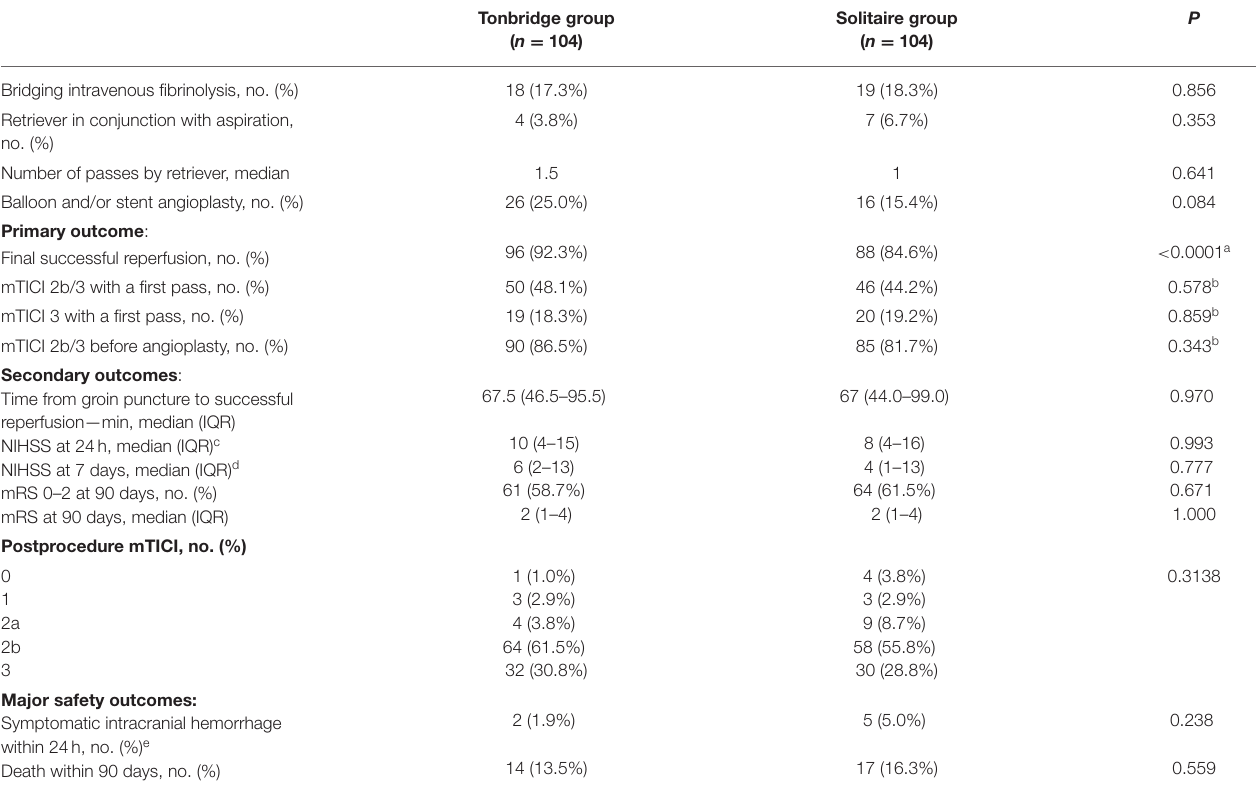
TABLE 2 | Procedural and outcomes data.